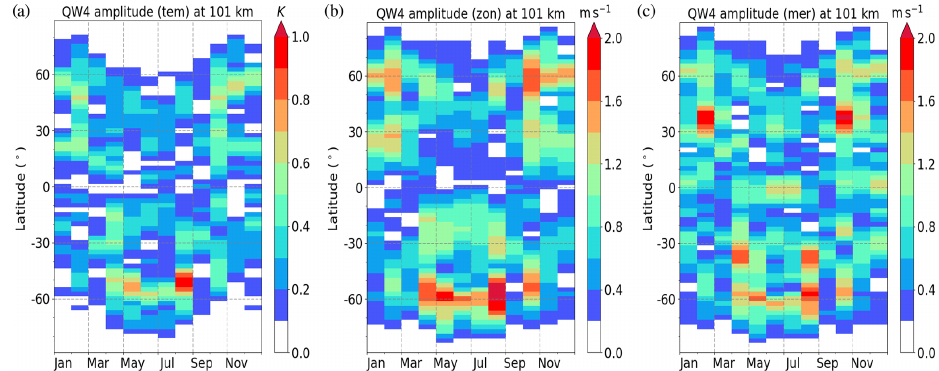
Figure 1. REF monthly mean QDT amplitudes at an altitude of 101km. From left to right: (a) temperature, (b) zonal wind and (c) meridional wind.